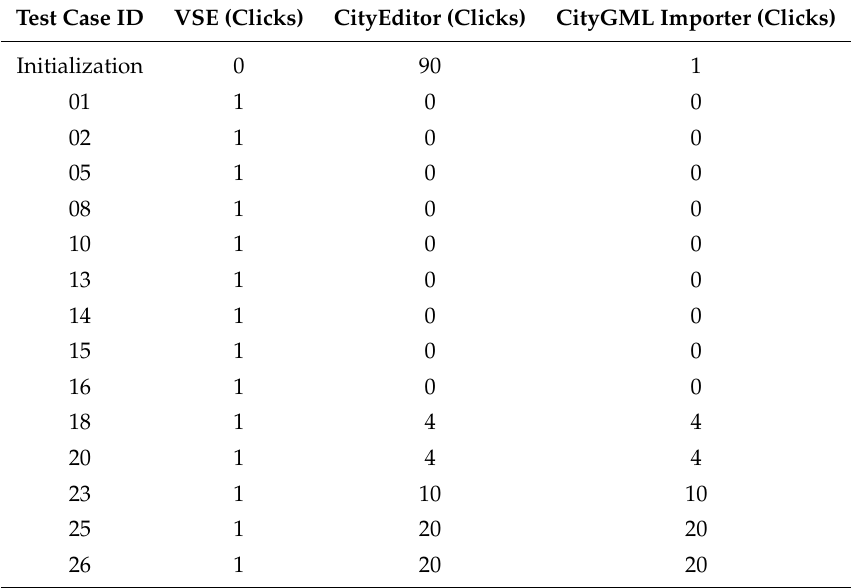
Table 2. Comparisons among VSE, CityEditor, and CityGML